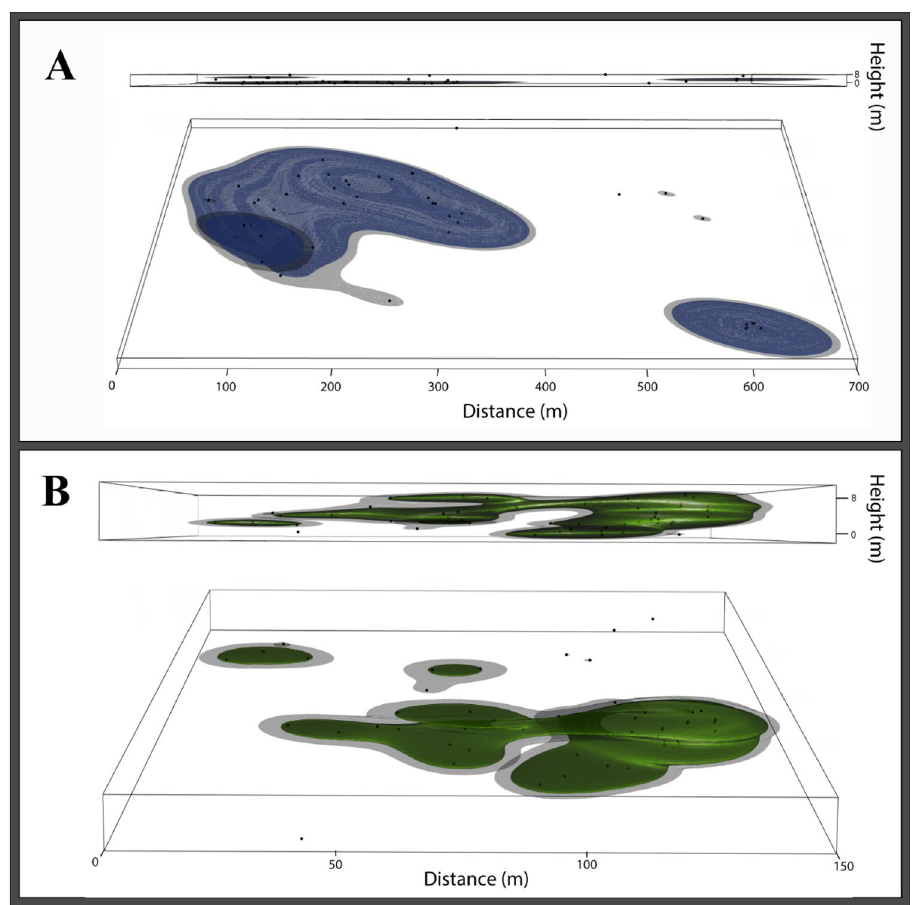
Figure 4. Examples of large (18.53 ha 3 ) and small (3.06 ha 3 ) 3D activity volumes from two male brown treesnakes ( Boiga irregularis ) with 1820 mm snout-vent length (SVL) ( A , blue 75% isopleths surrounded by grey 95% isopleths) and a 982 mm SVL ( B , green 75% isopleths surrounded by grey 95% isopleths). Two plots are shown in each panel, one from the lateral perspective as if you were standing on the ground (height = 0) and the other from approximately 45° angle from above. Note how both 3D activity volumes approximate a series of oblate spheroid